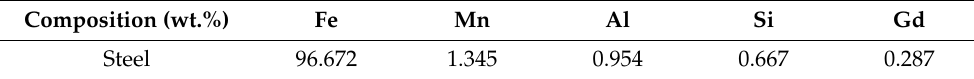
Table 2. Chemical composition of high-Al TRIP steel obtained from X-ray fluorescence. Steel Composition (wt.%)